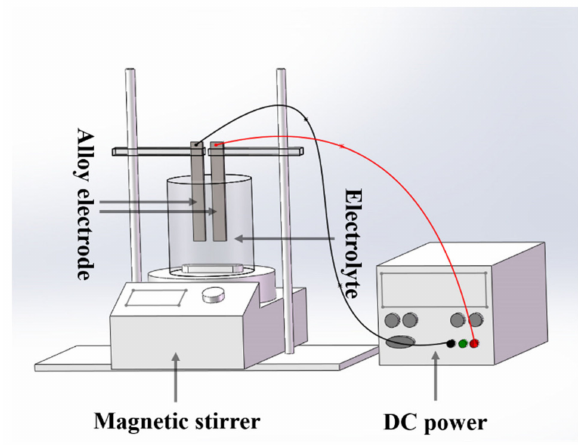
Figure 1. Schematic diagram of the electrochemical electrolytic